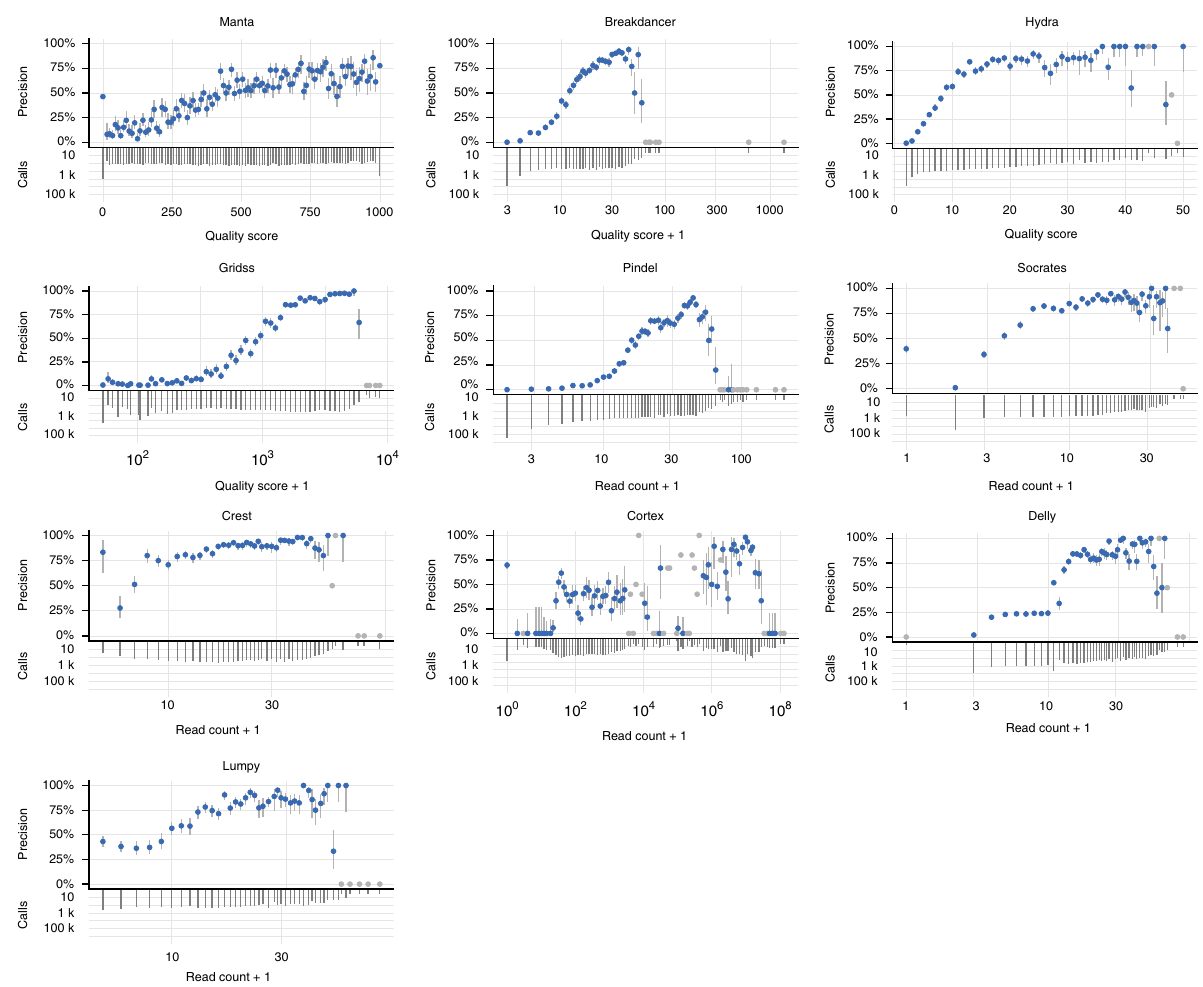
Fig. 4 Calls with the highest read depth or quality score are often false positives. For each caller, the results for the NA12878 dataset were separated into 100 bins by either (log) read count or quality score, as indicated. For each bin, the precision (upper plot) and number of calls falling within the bin (lower plot) was calculated. Grey bars indicate 95% binomial con fi dence intervals for the precision. Bins with 10 or fewer calls are coloured grey and con fi dence interval bar